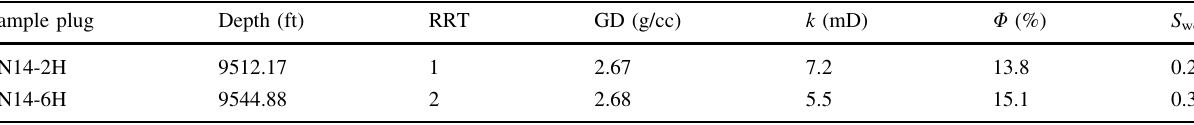
Table 9 Summary of core plug samples